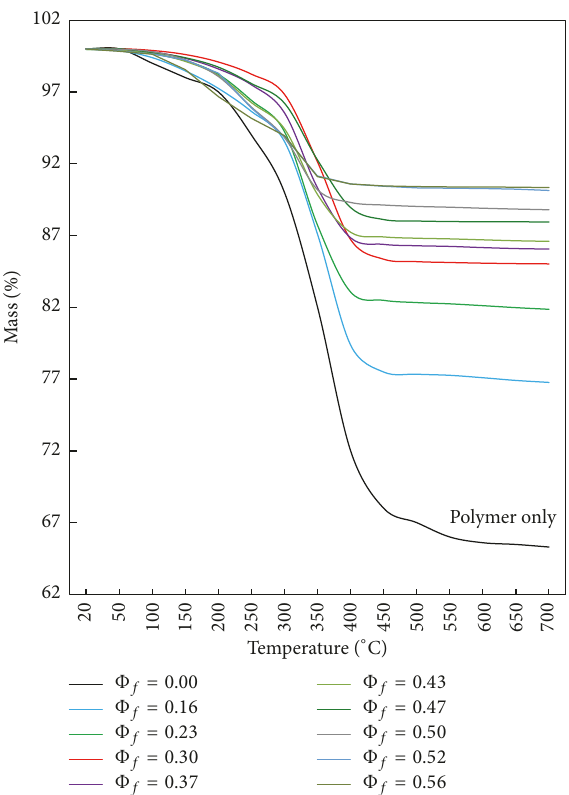
Figure 5: TGA curves of P/C powder composite specimens for different weight percentage of copper filler.